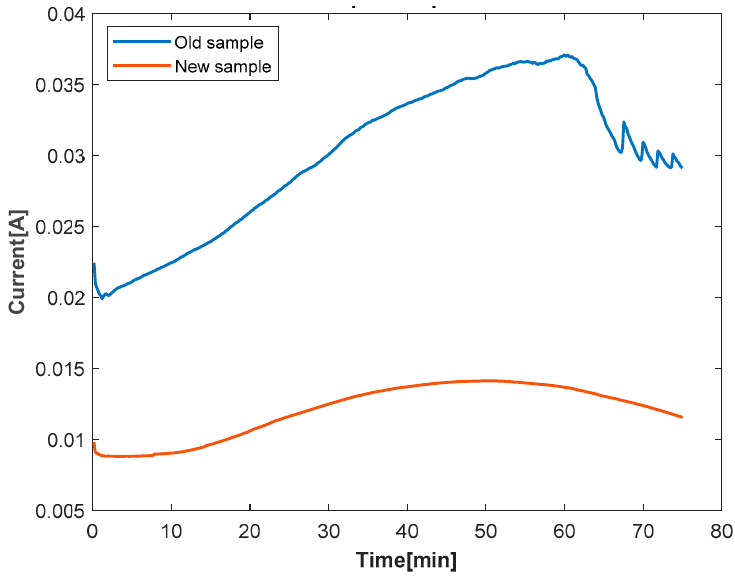
Figure 5. Current according to the CNF solution sample.